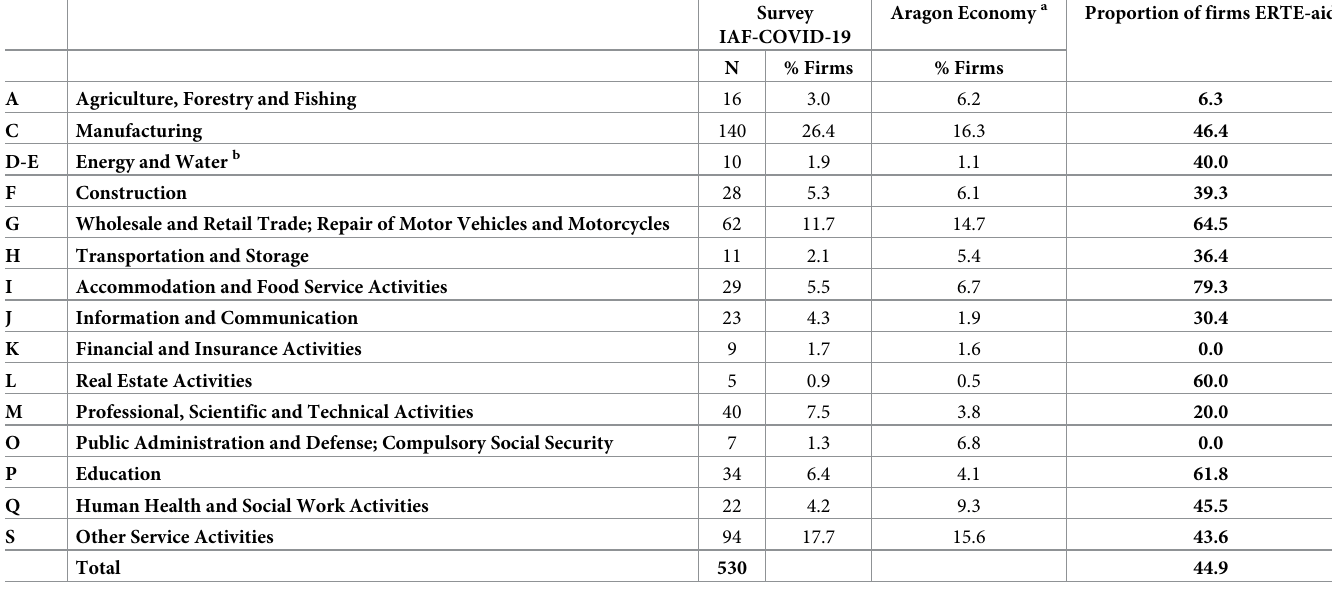
Table 1. Distribution of the sample of responding firms by economic sector.